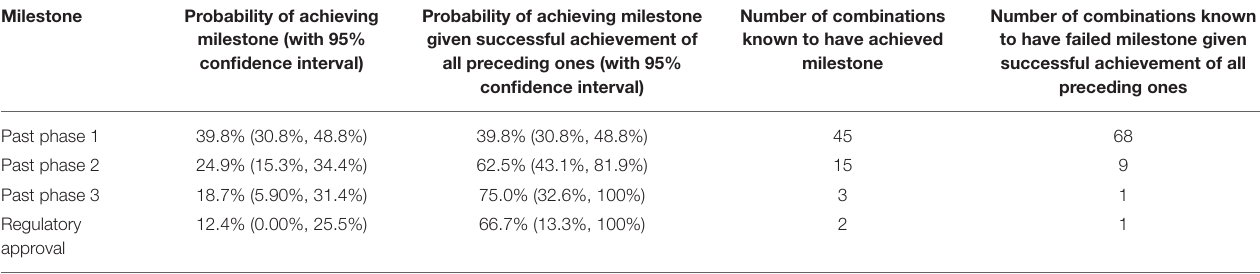
TABLE 1 | Summary statistics for the advancement of combinations past the various milestones in clinical trial development. Milestone